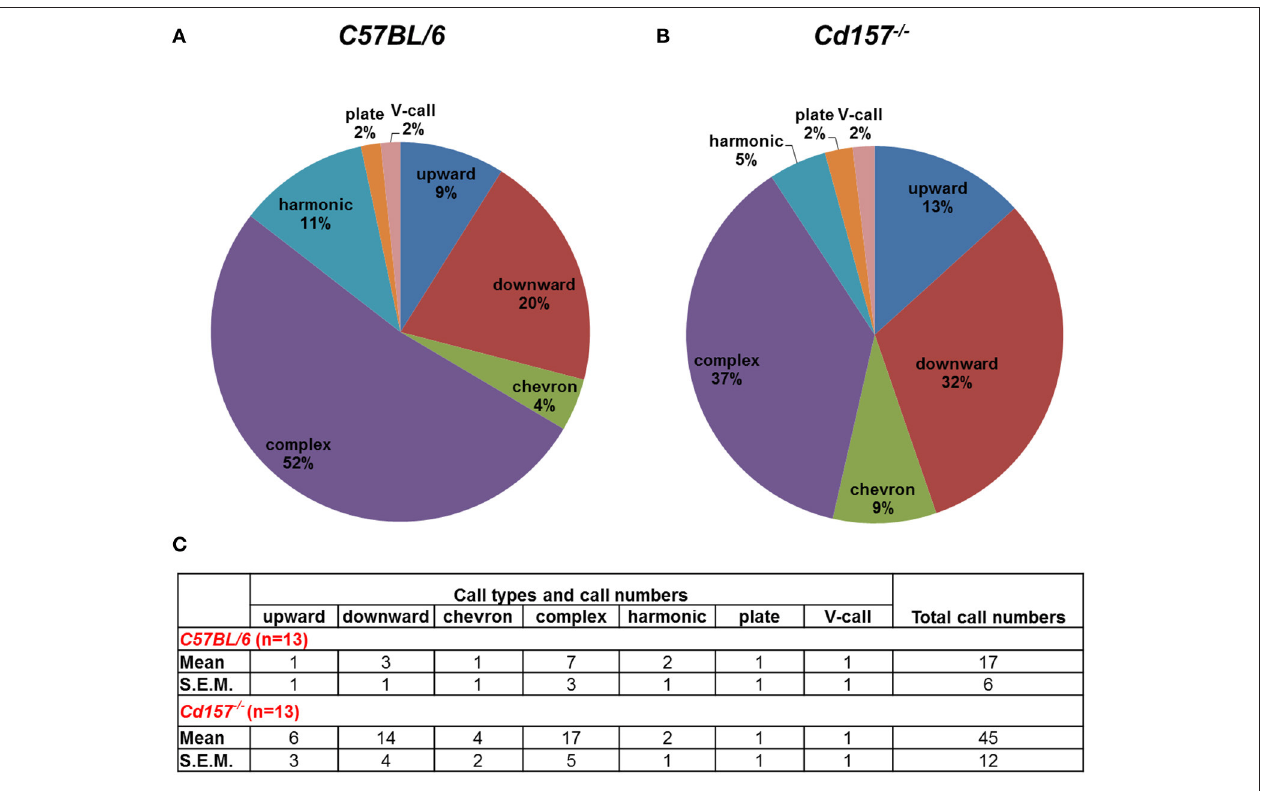
FIGURE 4 | Call category outline of USVs in adult Cd157 + / + and Cd157 − / − male mice. A wild-type ( C57BL/6 , A ) or Cd157 − / − (B) mouse was placed with a virgin female stranger mouse. USVs recorded during courtship were calculated as the number of calls in each category for each subject/total number of calls analyzed in each subject as a percentage. The recorded data of calls are presented in the (C) . The number of pairs tested = 8–10 and number of calls analyzed = 100–120.